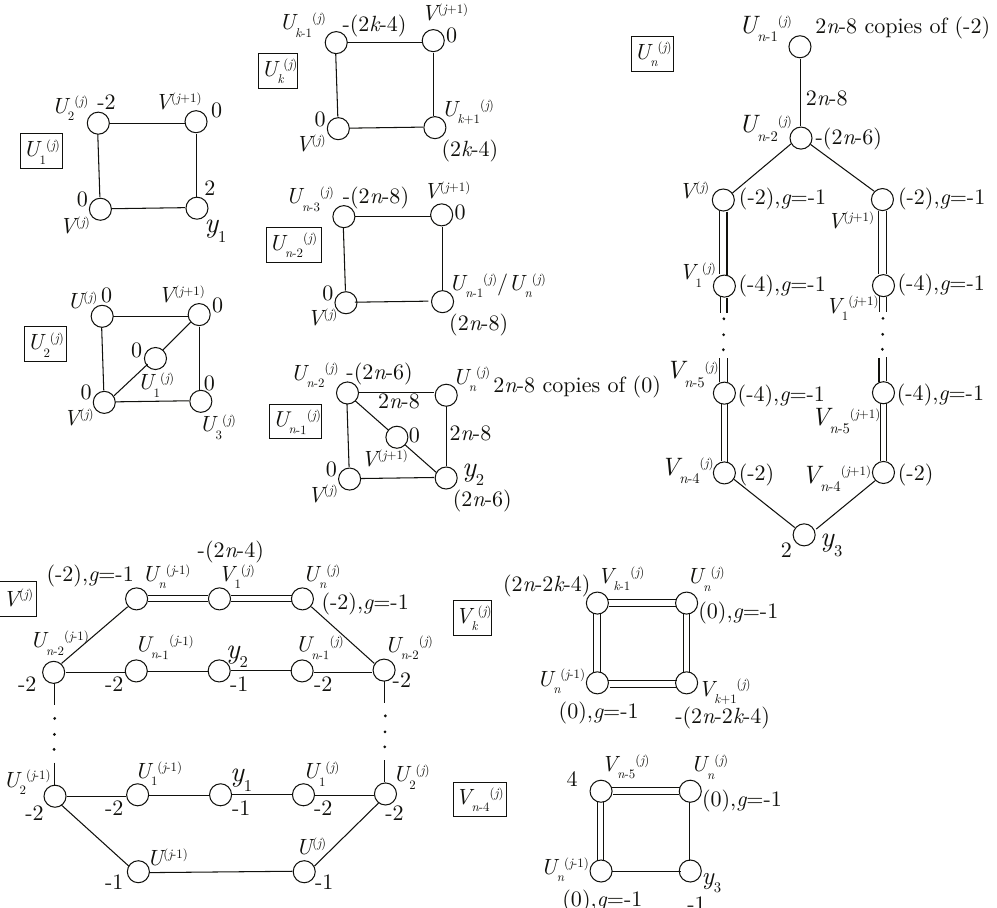
Figure 8. The con(cid:12)guration of curves in the decoupled and (cid:13)opped geometry of (cid:12)gure 7. Note that the decompacti(cid:12)ed surfaces U ( j ) has been